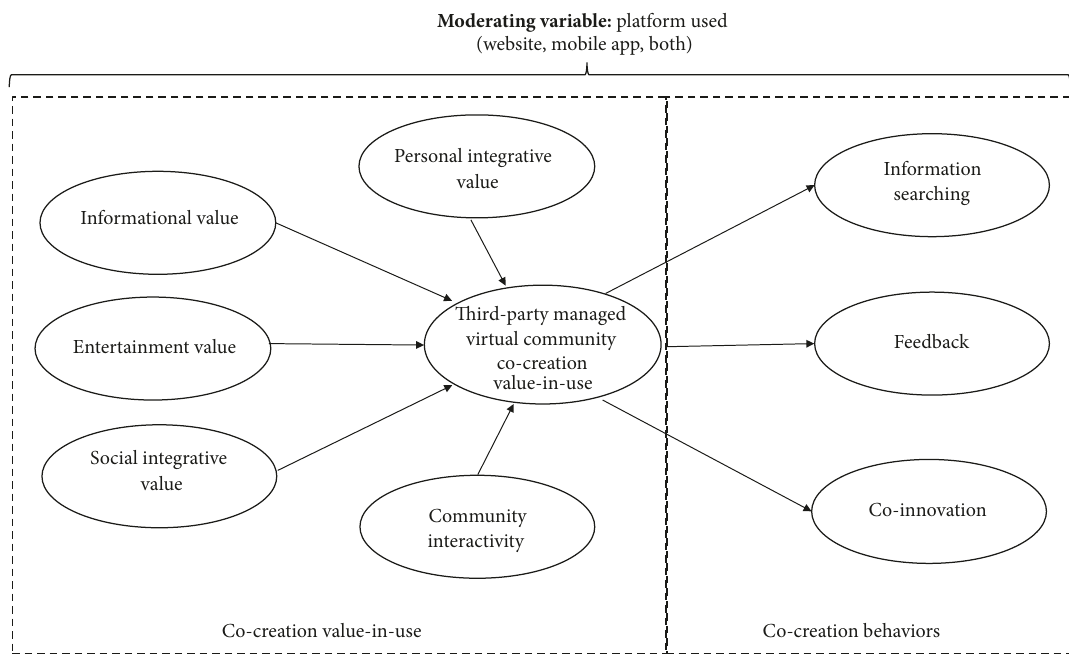
Figure 1: Theoretical research